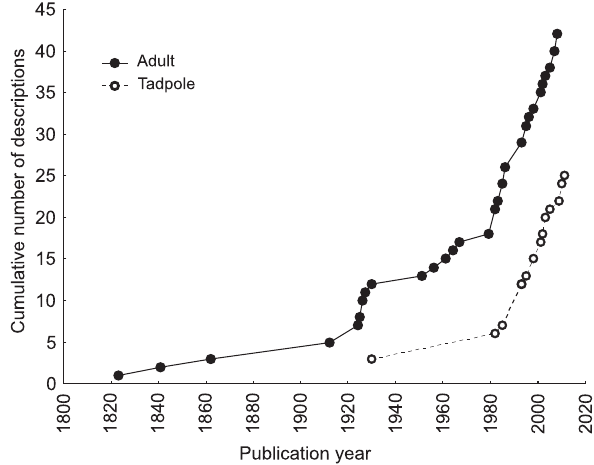
Figure 1. Cumulative number of descriptions of Hylodidae species through time. (  ) Adult forms, (  ) larval